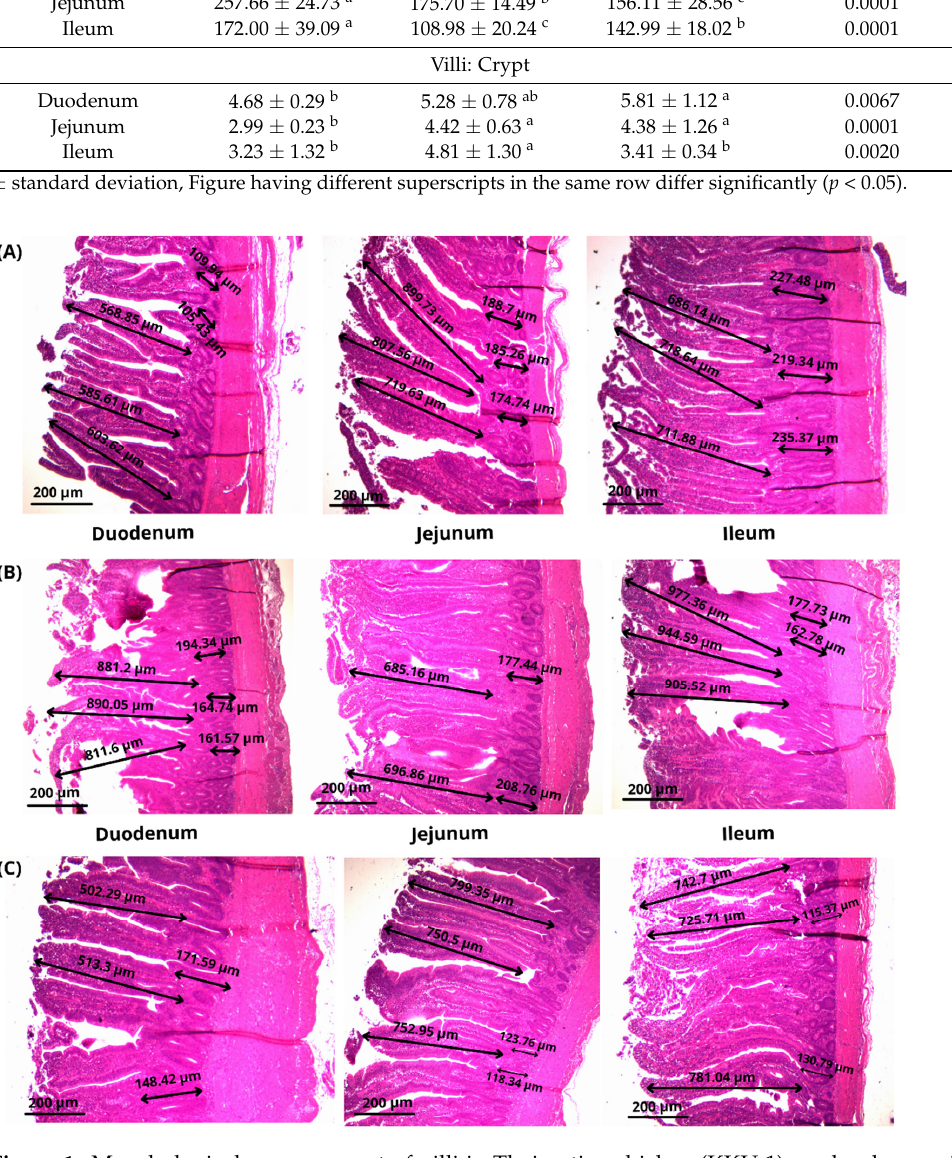
Figure 1. Morphological measurement of villi in Thai native chicken ( KKU 1 ) on duodenum, jejunum, and ileum, fed with citric acid by - product from rice ( CABR ) , ( A ) control, ( B ) CABR 3 % , and ( C ) CABR 6 % .